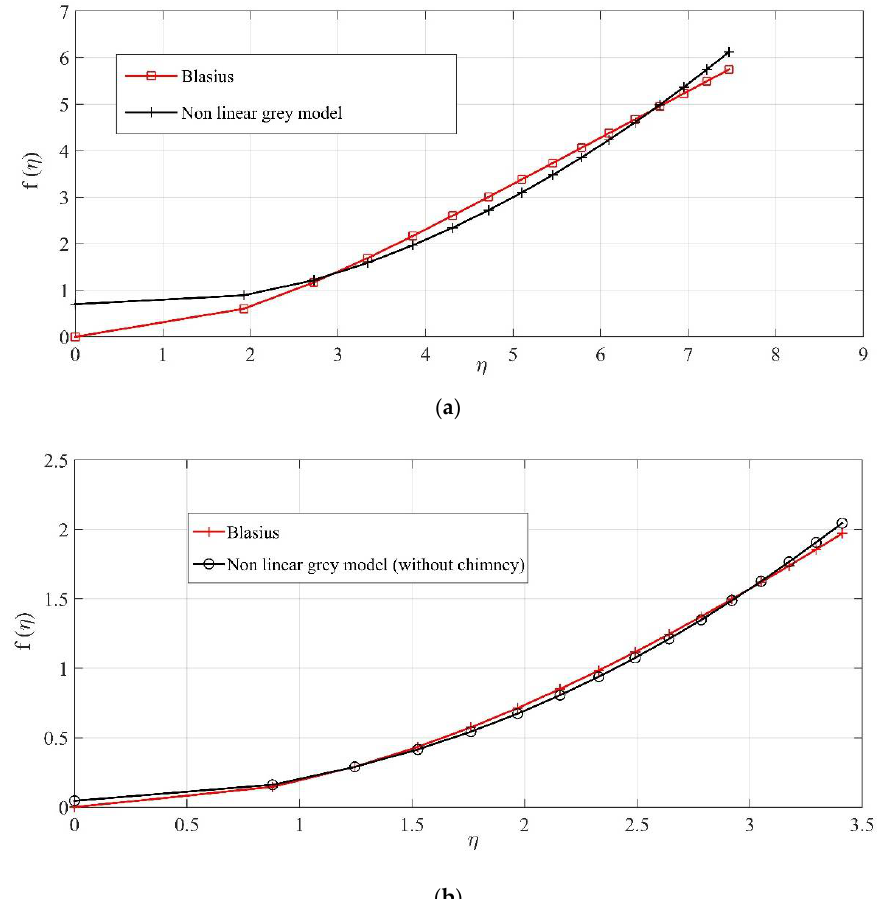
Figure 4. The change in the integral function ( f ( η )) to stretching factor: ( a ) chimney, ( b ) without chimney.